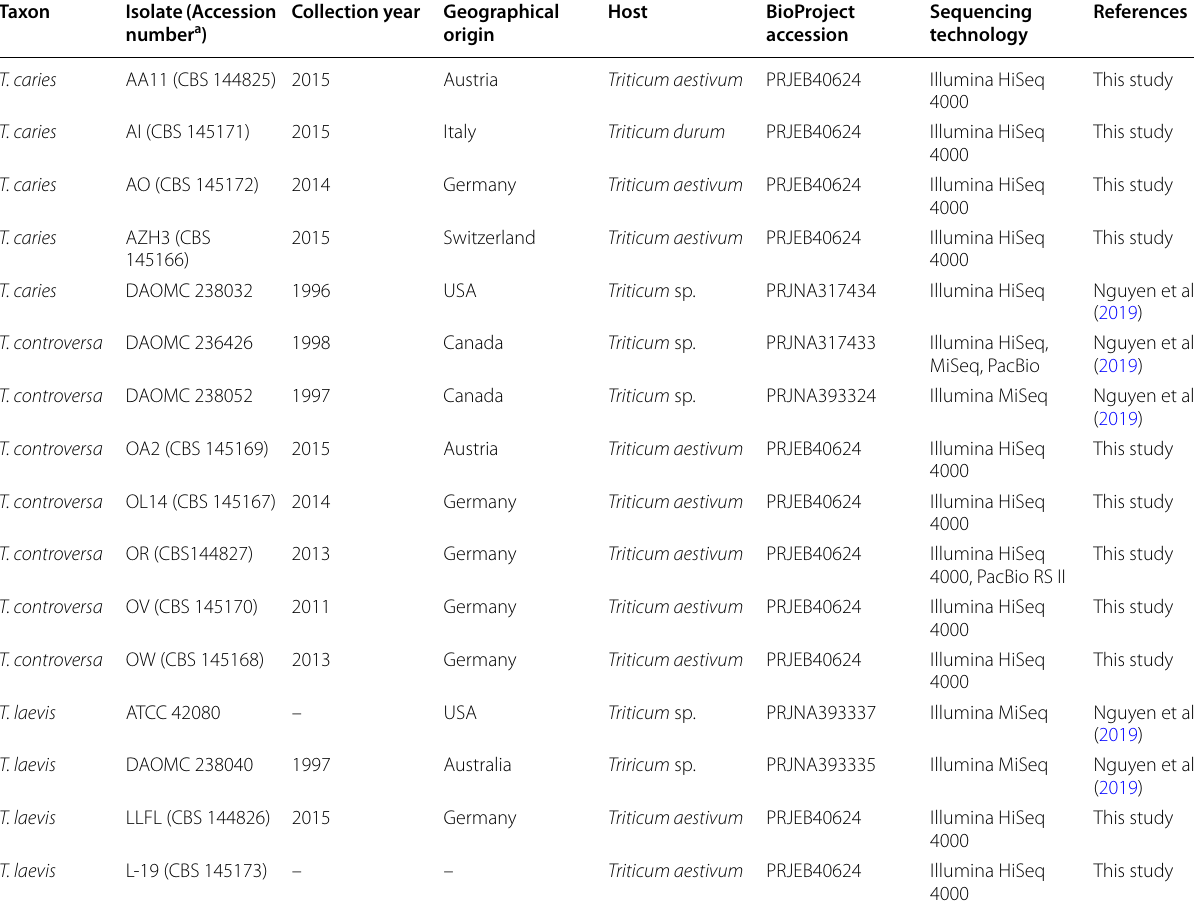
Table 1 List of the Tilletia isolates used for genome